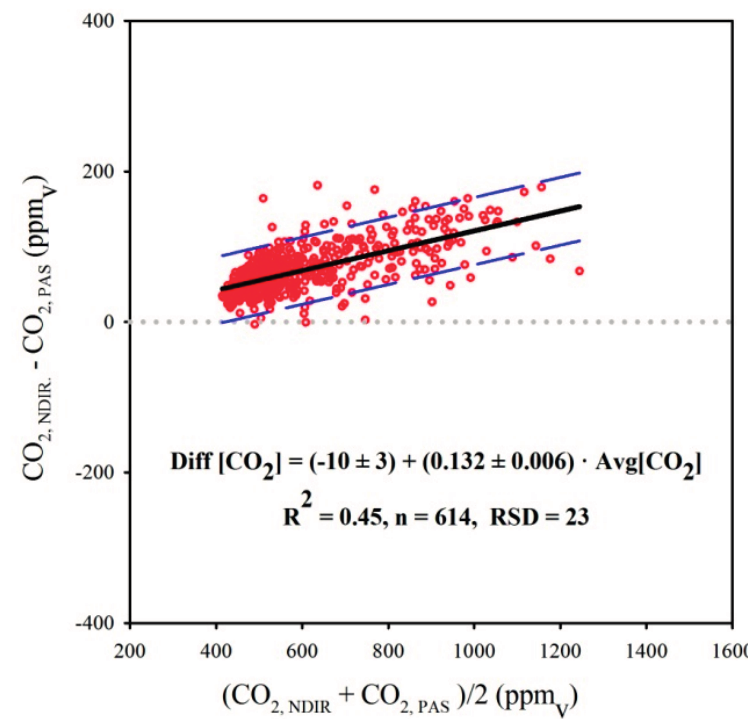
Figure 9. Bland-Altman chart for the relationship of CO 2 concentration determined with NDIR sensors and PAS analyzers. The dashed blue lines represent the 95% confidence